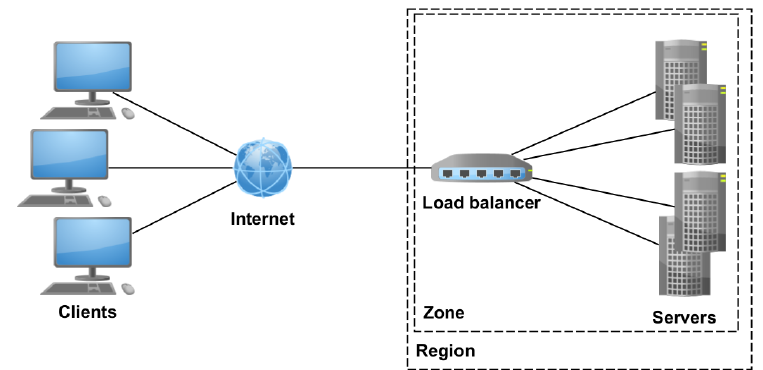
Figure 1. Web cloud system diagram.